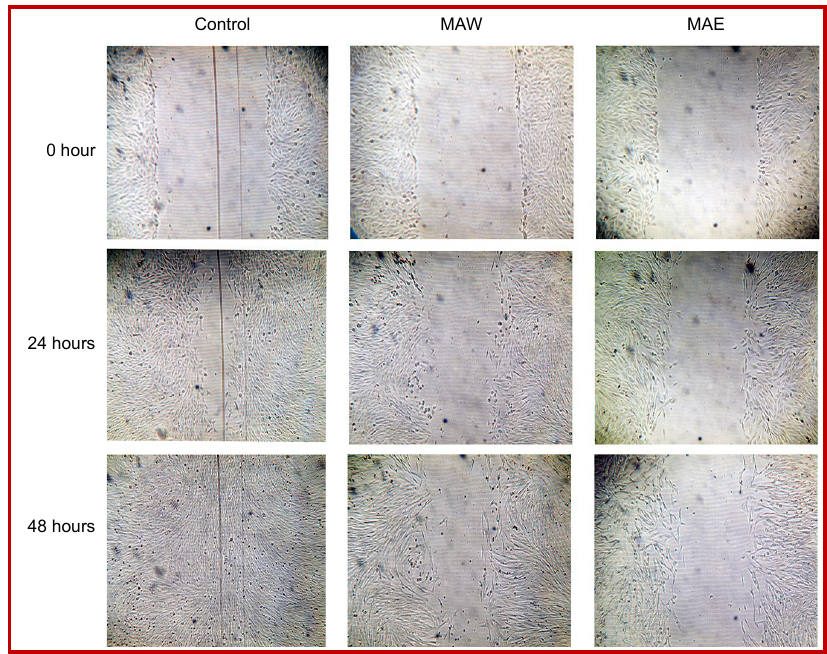
Figure 4: Effects of Mahonia aquifolium water (MAW) and ethanol (MAE) extracts on endothelial cell migration. Applied concentra- tions for MAW was 79.7 µg/mL for MAE was 48.26 µg/mL. Representative photomicrographs of one out of three independent experiments are shown